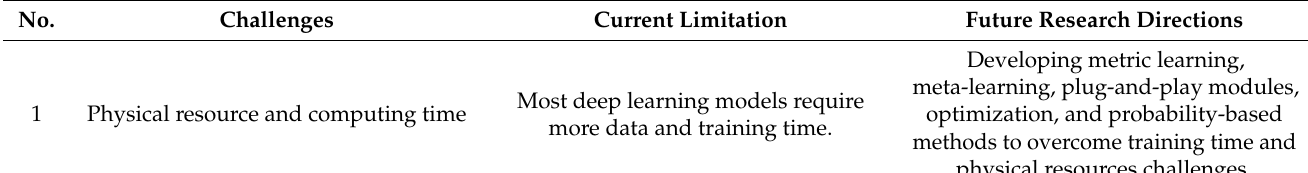
Table 6. Current challenges and future research directions.